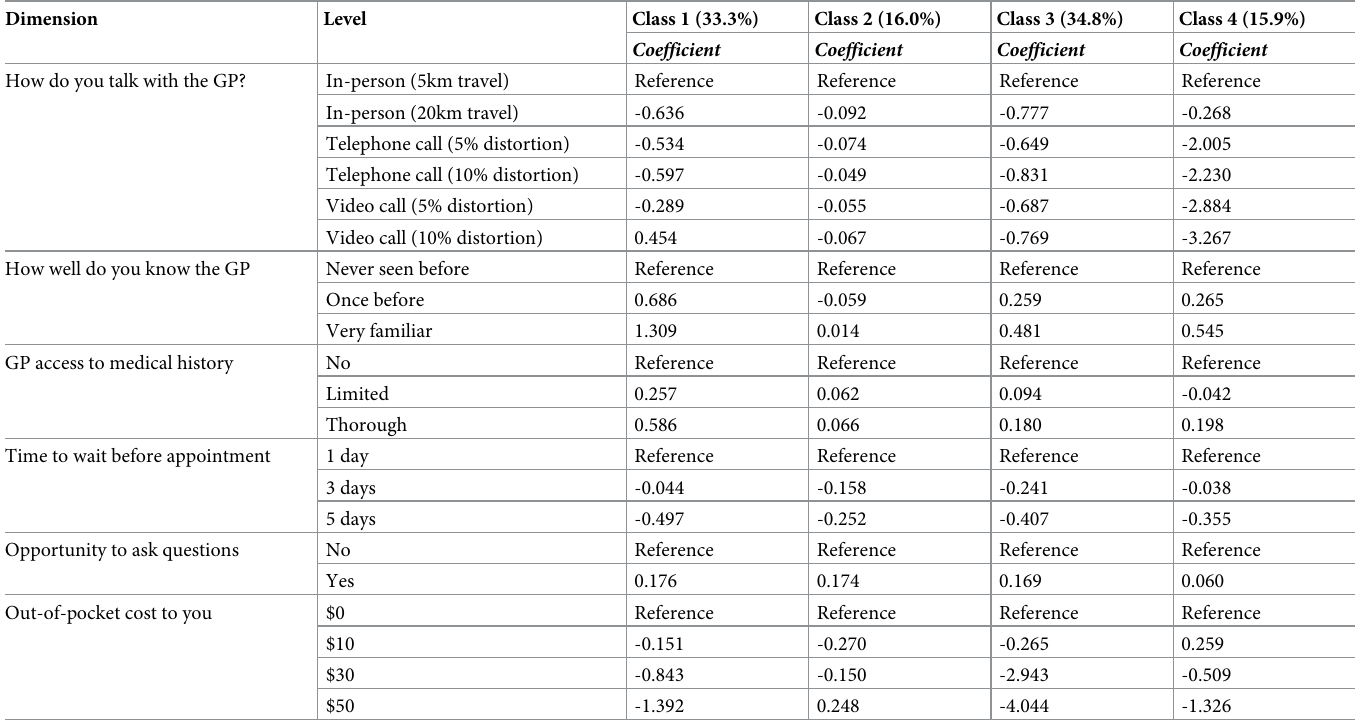
Table 5. Latent class